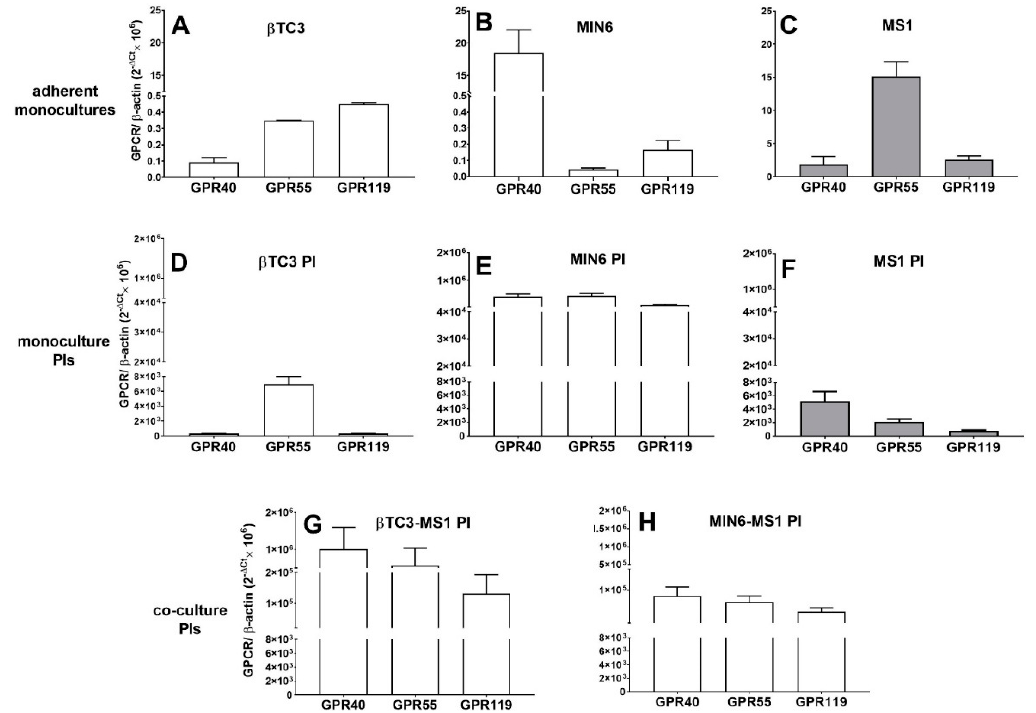
Figure 8. Comparison of GPCR expression patterns in adherent monocultures of β TC3 ( A ), MIN6 ( B ), and MS-1 ( C ) with their respective monocultures in the form of 3D pseudoislets ( D , E , and F , respectively) and the co-cultured pseudoislets: β TC3-MS1 PI ( G ) and MIN6-MS1 PI ( H ). This approach failed in the case of β TC3 PI, confirming the impaired nature of this cell